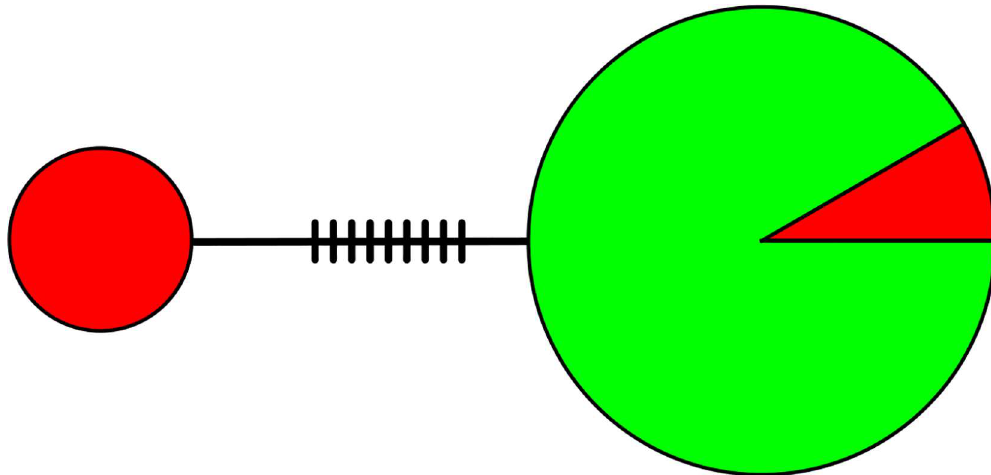
Fig 3. Median Joining networkbased on 311bp of the mtDNAcontrol region for 11 Razor-billed Curassows (left circle), and for 72 animalsassigned to Alagoas Curassowbased on the stringent analyses and Structure analysesusing 98%threshold (right circle),with circlesizesreflecting the numbers of individuals. Greenand red colorsrepresentAlagoasandRazor-billedCurassow haplotypes, respectively,indicatingRazor-billedmaternal ancestryfor six individualsassignedto AlagoasCurassowbasedon morphologyandmicrosatellites.Hatches representunobserved